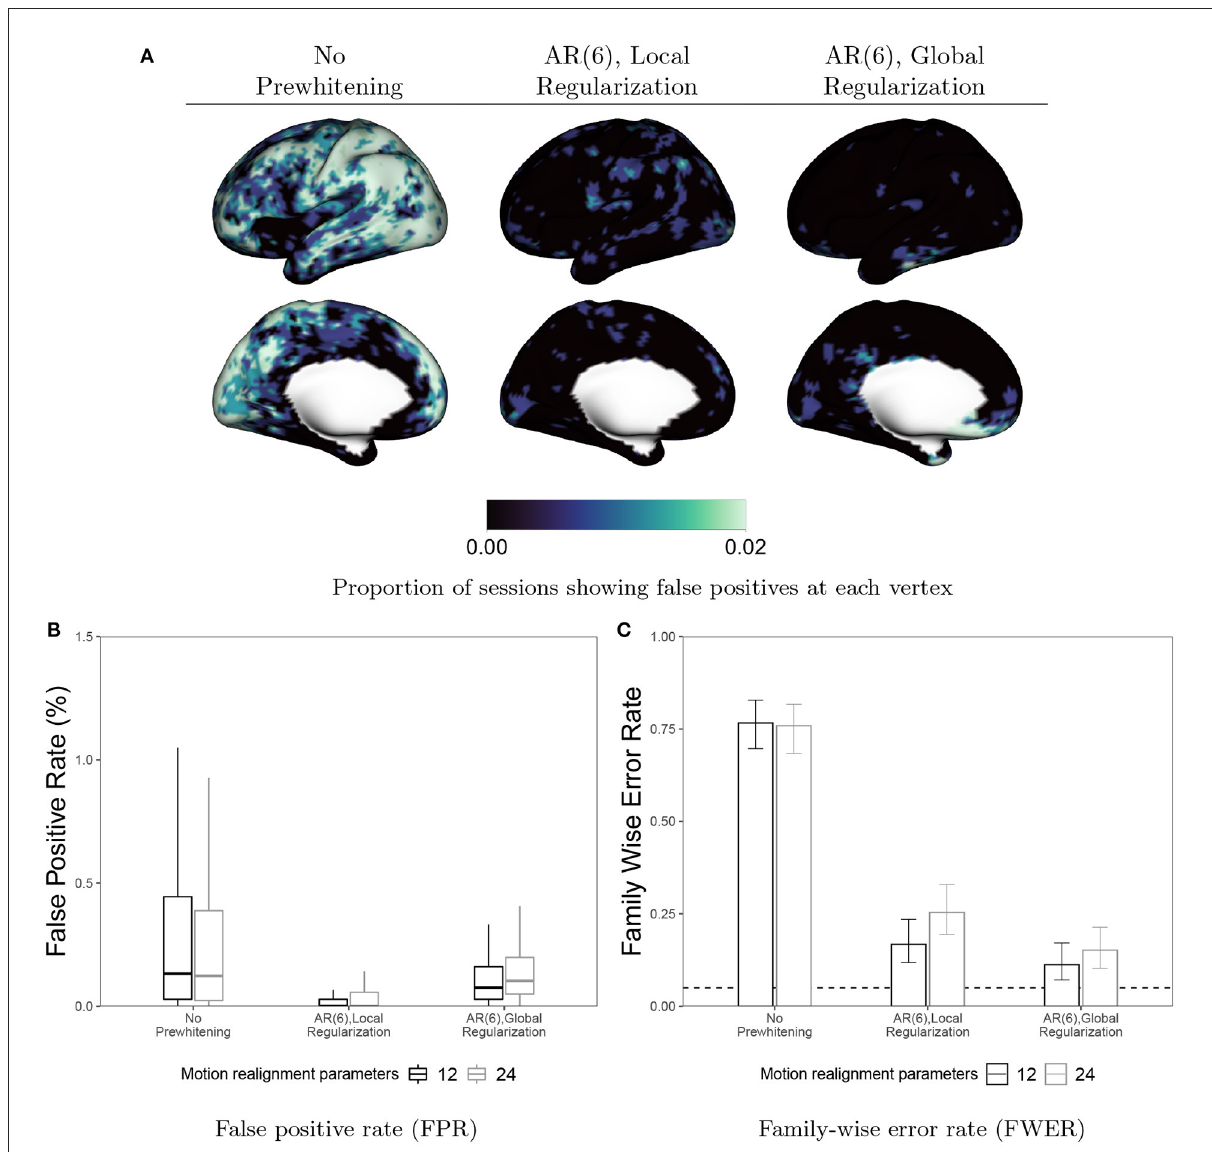
FIGURE11 False positives in resting-state data before and after prewhitening. (A) Values at each vertex represent the proportion of sessions where a false positive is detected. (B) Boxplots representing the distribution across all sessions and subjects of the FPR, defined as the proportion of vertices flagged as false positives for a given scan. (C) FWER with 95 % Agresti-Coull confidence intervals for proportions. Prewhitening dramatically reduces false positive rates and brings FWER close to the nominal rate of 0.05 (dashed line). Local regularization of prewhitening parameters achieves near-zero FPR across nearly all sessions. Interestingly, including additional motion covariates (24 vs. 12) seems to worsen both FPR and FWER when used alongside